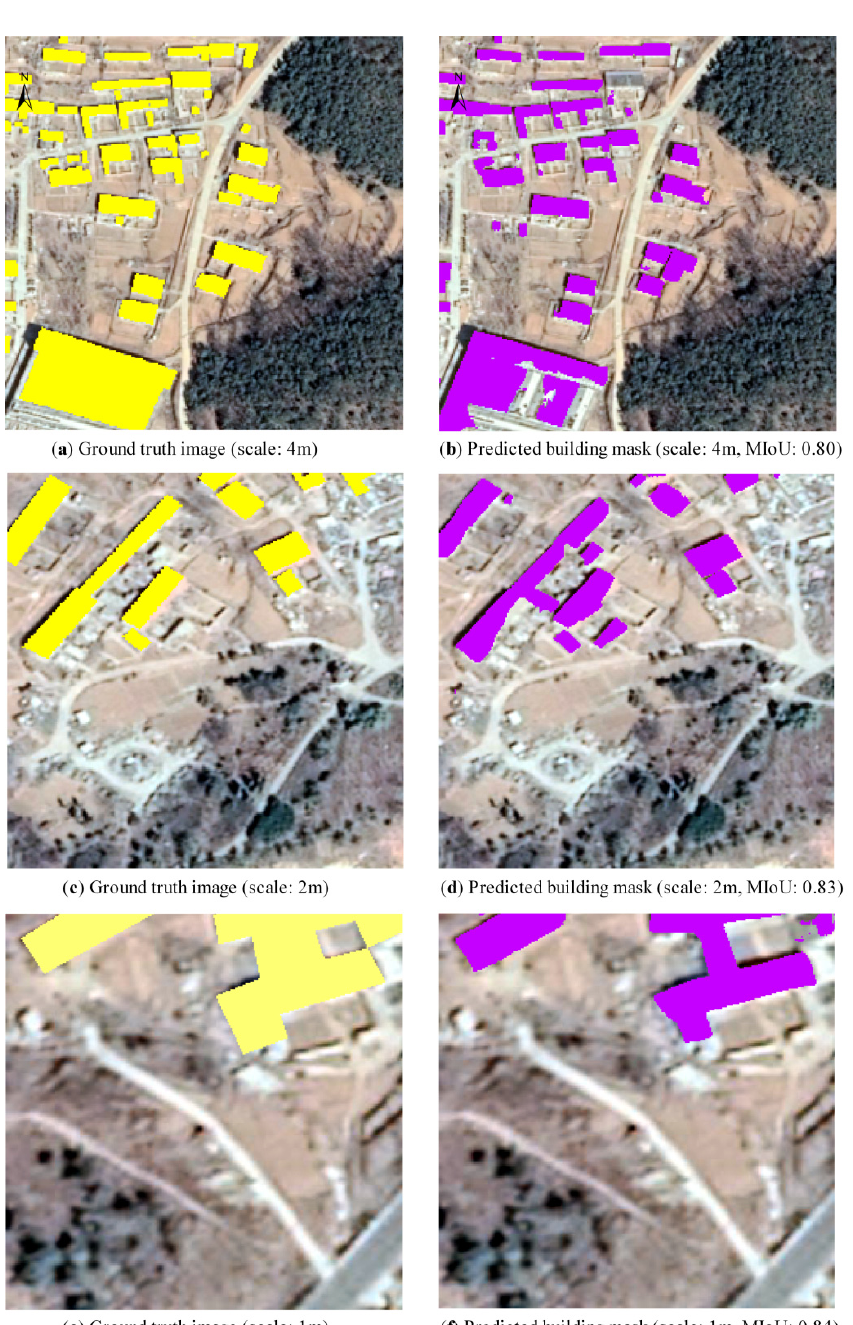
Figure 8. Comparison of original RGB images, ground truth masks and predicted masks at three spatial